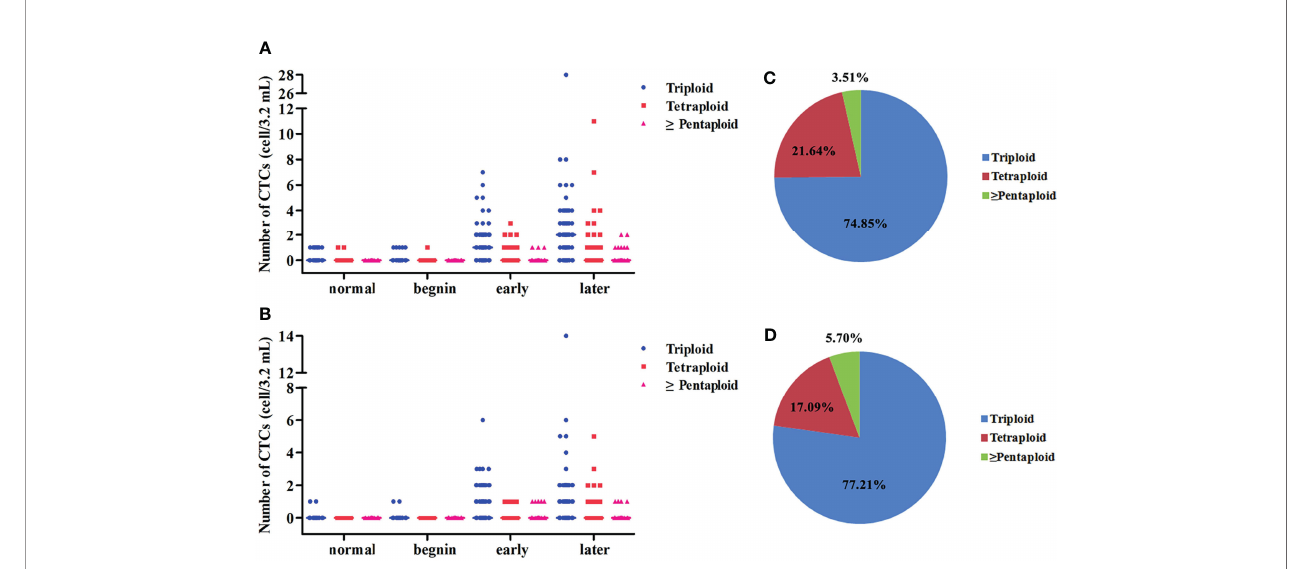
FIGURE 4 | (A) Scatter plots for the distribution of CTCs ’ chromosome VIII ploidy for normal, benign, early- stage, and late-stage patients. (B) Scatter plots for the distribution of CTCs ’ chromosome VII ploidy for normal, benign, early-stage, and late-stage patients. (C) Pie charts for the proportion of CTC with different types of chromosomal VIII ploidy for EC patients. (D) Pie charts for the proportion of CTC with different types of chromosomal VII ploidy for EC